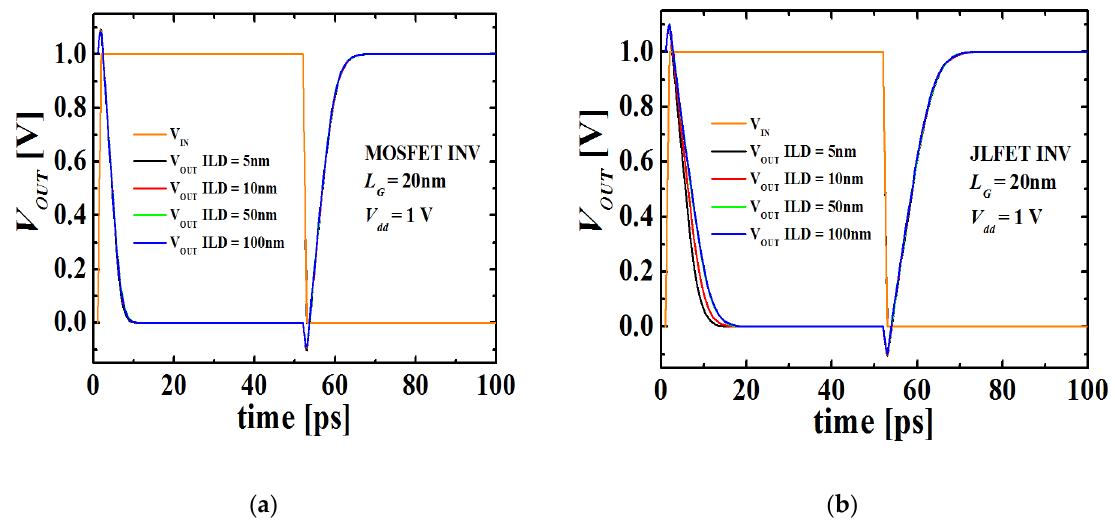
Figure 10. Transient responses at different T ILD s. ( a ) M3INV-MOS cell and ( b ) M3INV-JL cell. Here L G = 20 nm and V dd = 1 V. Table 2. Propagation delay of M3INV-MOS and M3INV-JL at different L g s and T ILD s.